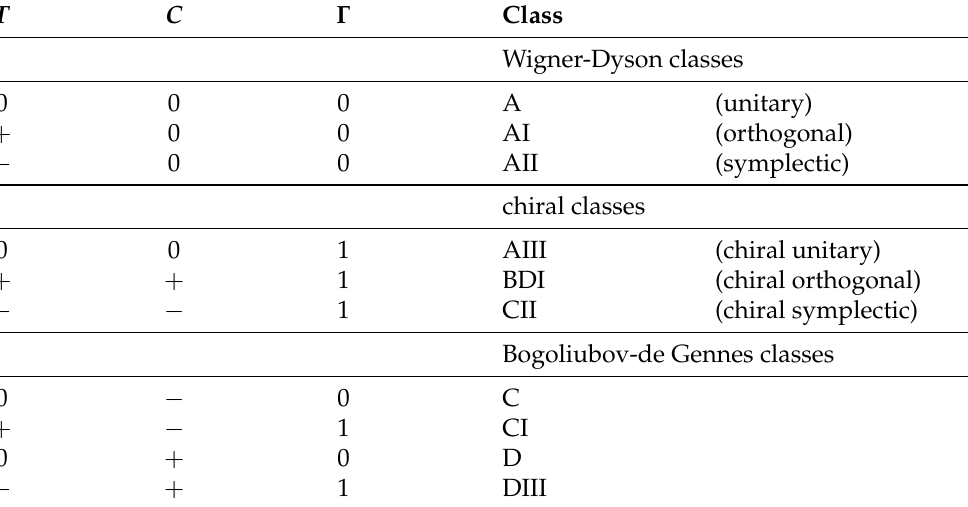
Table 1. Symmetry classes of random matrix ensembles. Entries corresponding to time-reversal ( T ) and particle-hole ( C ) symmetry indicate whether the symmetry is absent (0) or, if present, what is its square ( ); entries corresponding to chiral symmetry ( Γ ) indicate whether it is absent or present (0 ± or